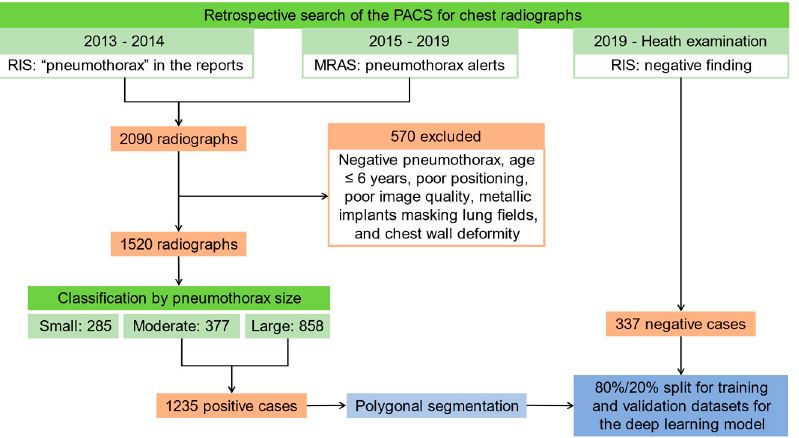
Figure 1. The flow chart of the data acquisition for the deep learning model for pneumothorax detection on chest radiographs. Abbreviations: PACS, Picture Archiving and Communication System; MRAS, Manual Radiology Alert System; RIS, Radiology Information System.